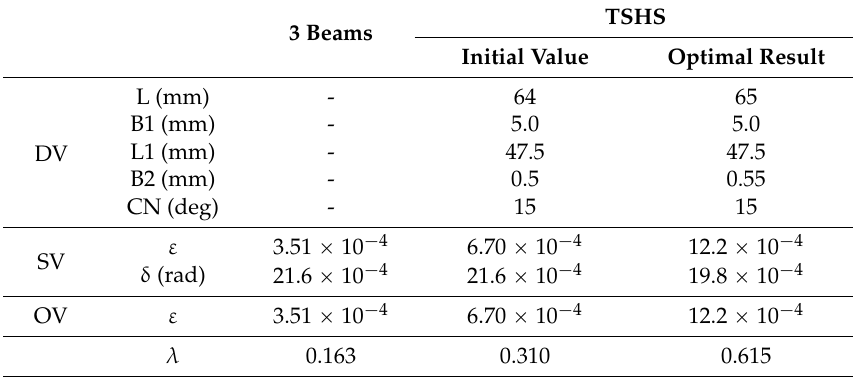
Figure 11. Torque sensors. ( a ) 3-beam torque sensor; ( b ) TSHS.